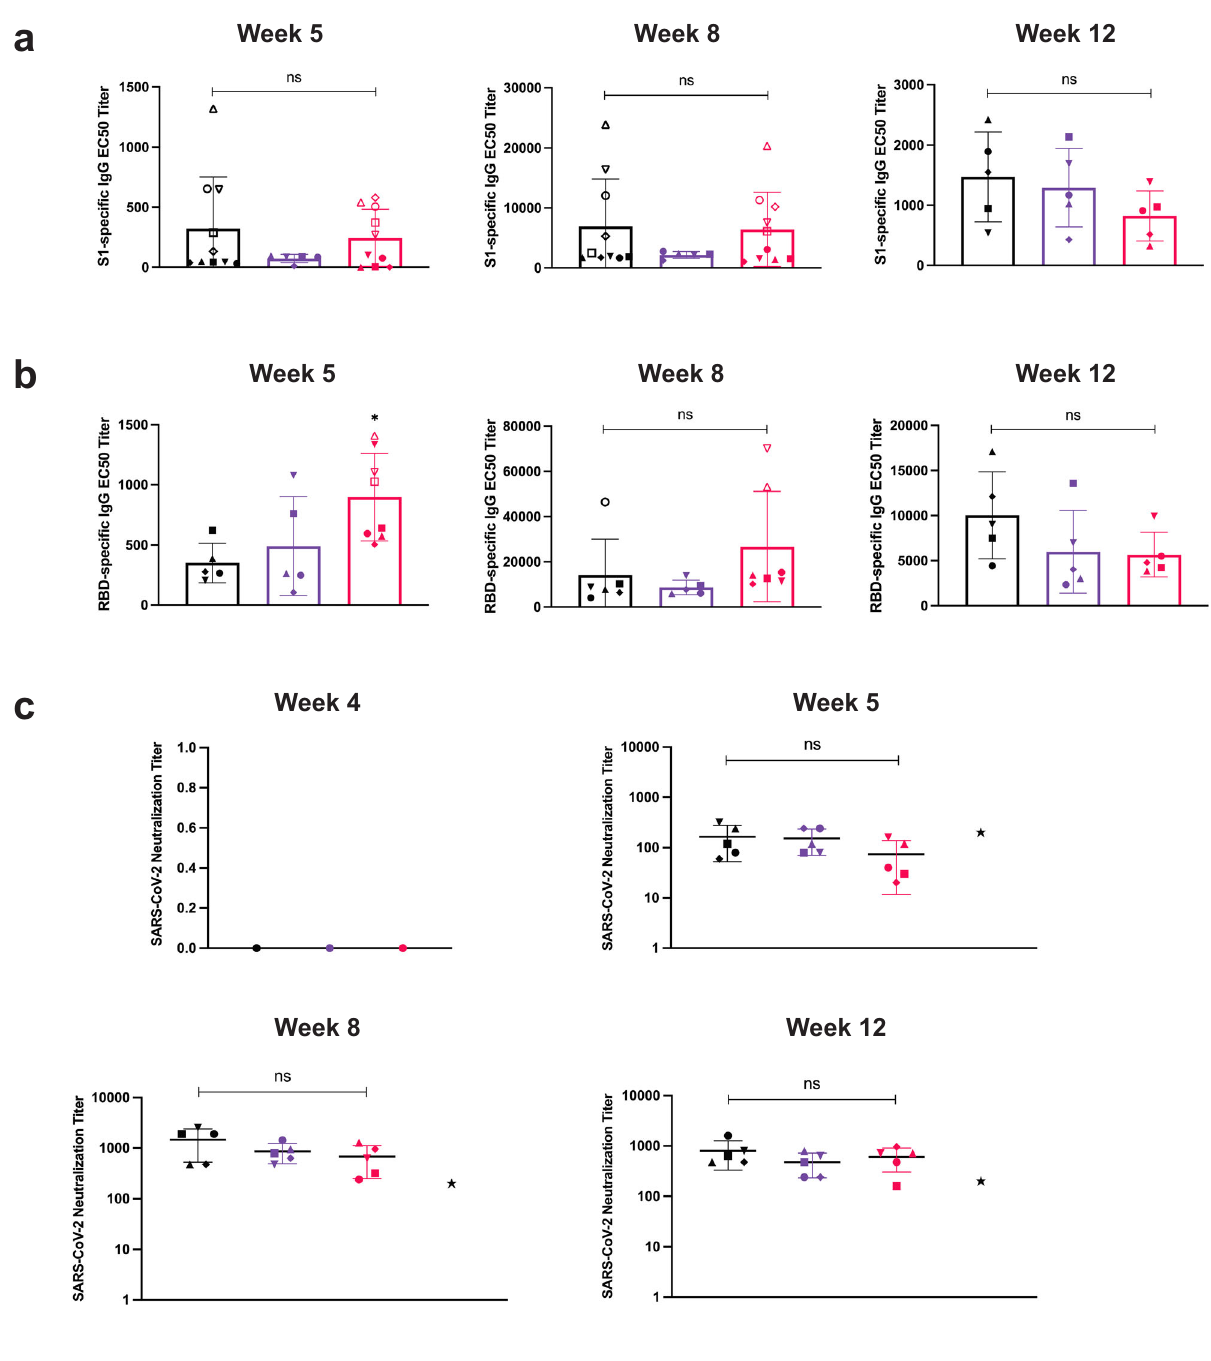
Fig. 3 Effect of pre-existing RABV immunity on SARS-CoV-2 speci fi c responses. a S1-speci fi c and b RBD-speci fi c IgG ELISA in CORAVAX- immunized mouse sera at weeks 8 – 12 following prior RABV immunity. The average IgG EC50 titers (bars) are determined from individual mouse (symbols) ELISA curves, including a pilot experiment (open symbols). c SARS-CoV-2 neutralization assay for log-transformed neutralizing antibody titers at week 4 before CORAVAX immunization and weeks 5 – 12 in CORAVAX-immunized mouse sera. The line represents the average neutralization titer per group of individual mice (symbols). The positive control serum (black star) is from a previous experiment of CORAVAX-immunized hamsters at week 8. Error bars represent SD from the mean. Statistics are by one-way ANOVA with post- hoc Tukey ’ s test of log-transformed EC50 or neutralizing titers. p > 0.1234 (ns), p < 0.0332 (*), p < 0.0021 (**), p < 0.0002 (***), p < 0.0001